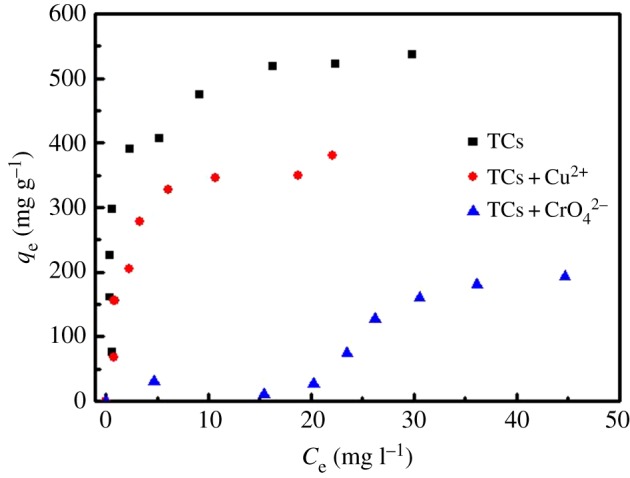
Equilibrium adsorption isotherms of coexisting Cu2+ and CrO42− with TC on G-KOH, respectively.